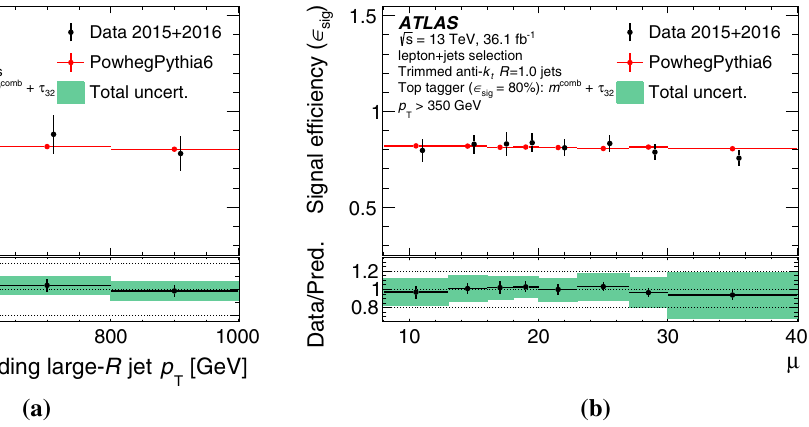
Fig. 19 The signal efficiency on contained top-quark jets for the two- variable m comb + τ 32 top-quark tagger as a function of the large- R jet p T ( a ) and the average number of interactions per bunch crossing μ ( b ) in data and simulation. Statistical uncertainties of the signal efficiency measurement in data and simulation are shown as error bars in the top panel. In the bottom panel, the ratio of the measured signal efficiency